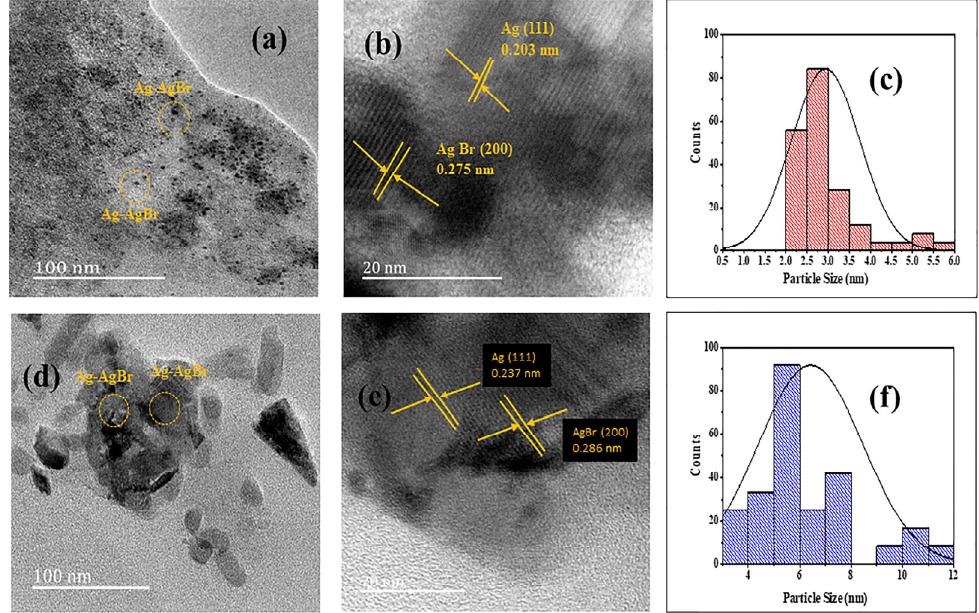
Figure 4. ( a , d ) Transmission electron micrographs, ( b , d ) high-resolution Transmission electron micrographs, and ( c , f ) particle diameter of the TP-AABR-ACK and DP-AABR-ACK photocatalysts.